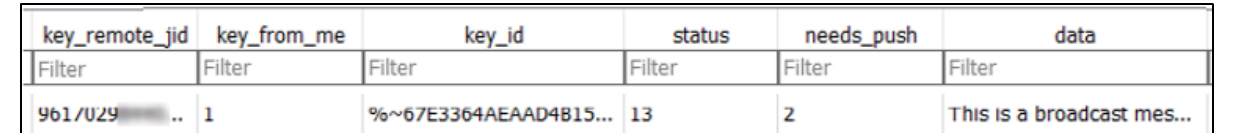
Figure 21. Broadcast records